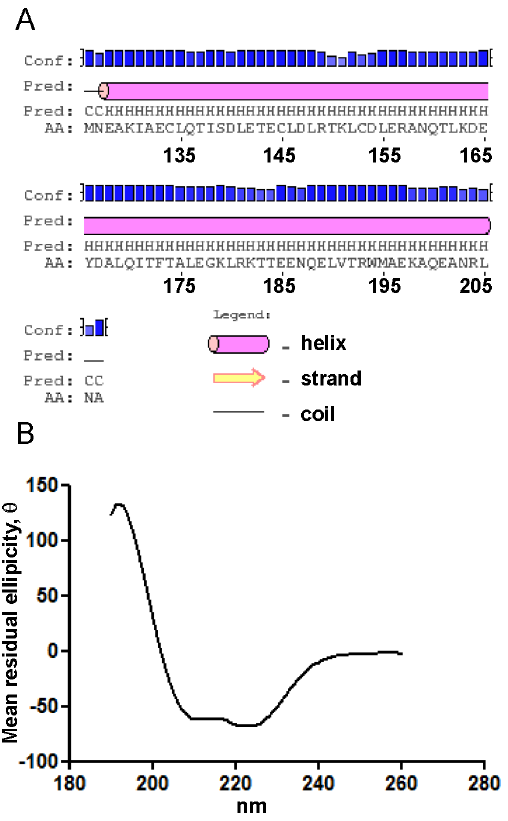
Figure 3. The coiled-coil of human ATG16L1 is alpha helical. (A) PSIPRED prediction of the secondary structure of the minimal coiled-coil domain (residues M126 – A207; CCD3) of human ATG16L1. Sequencing numbering corresponds to the human protein, alpha helices are marked as pink cylinders and the confidence level of the prediction for each residue is provided by the blue bars. (B) Circular dichroism analysis of CCD3. Mean residual ellipicity ( h ) plotted against wavelength (nm) indicates a helical protein.